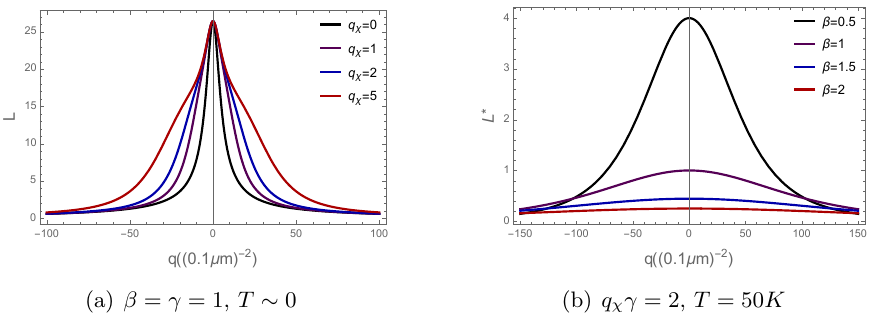
Figure 15 . (a) E(cid:11)ect of interaction strength q (cid:31) on Lorentz ratio near zero temperature. (b) E(cid:11)ect of impurity density on Lorentz ratio, L (cid:3) = L (cid:1)